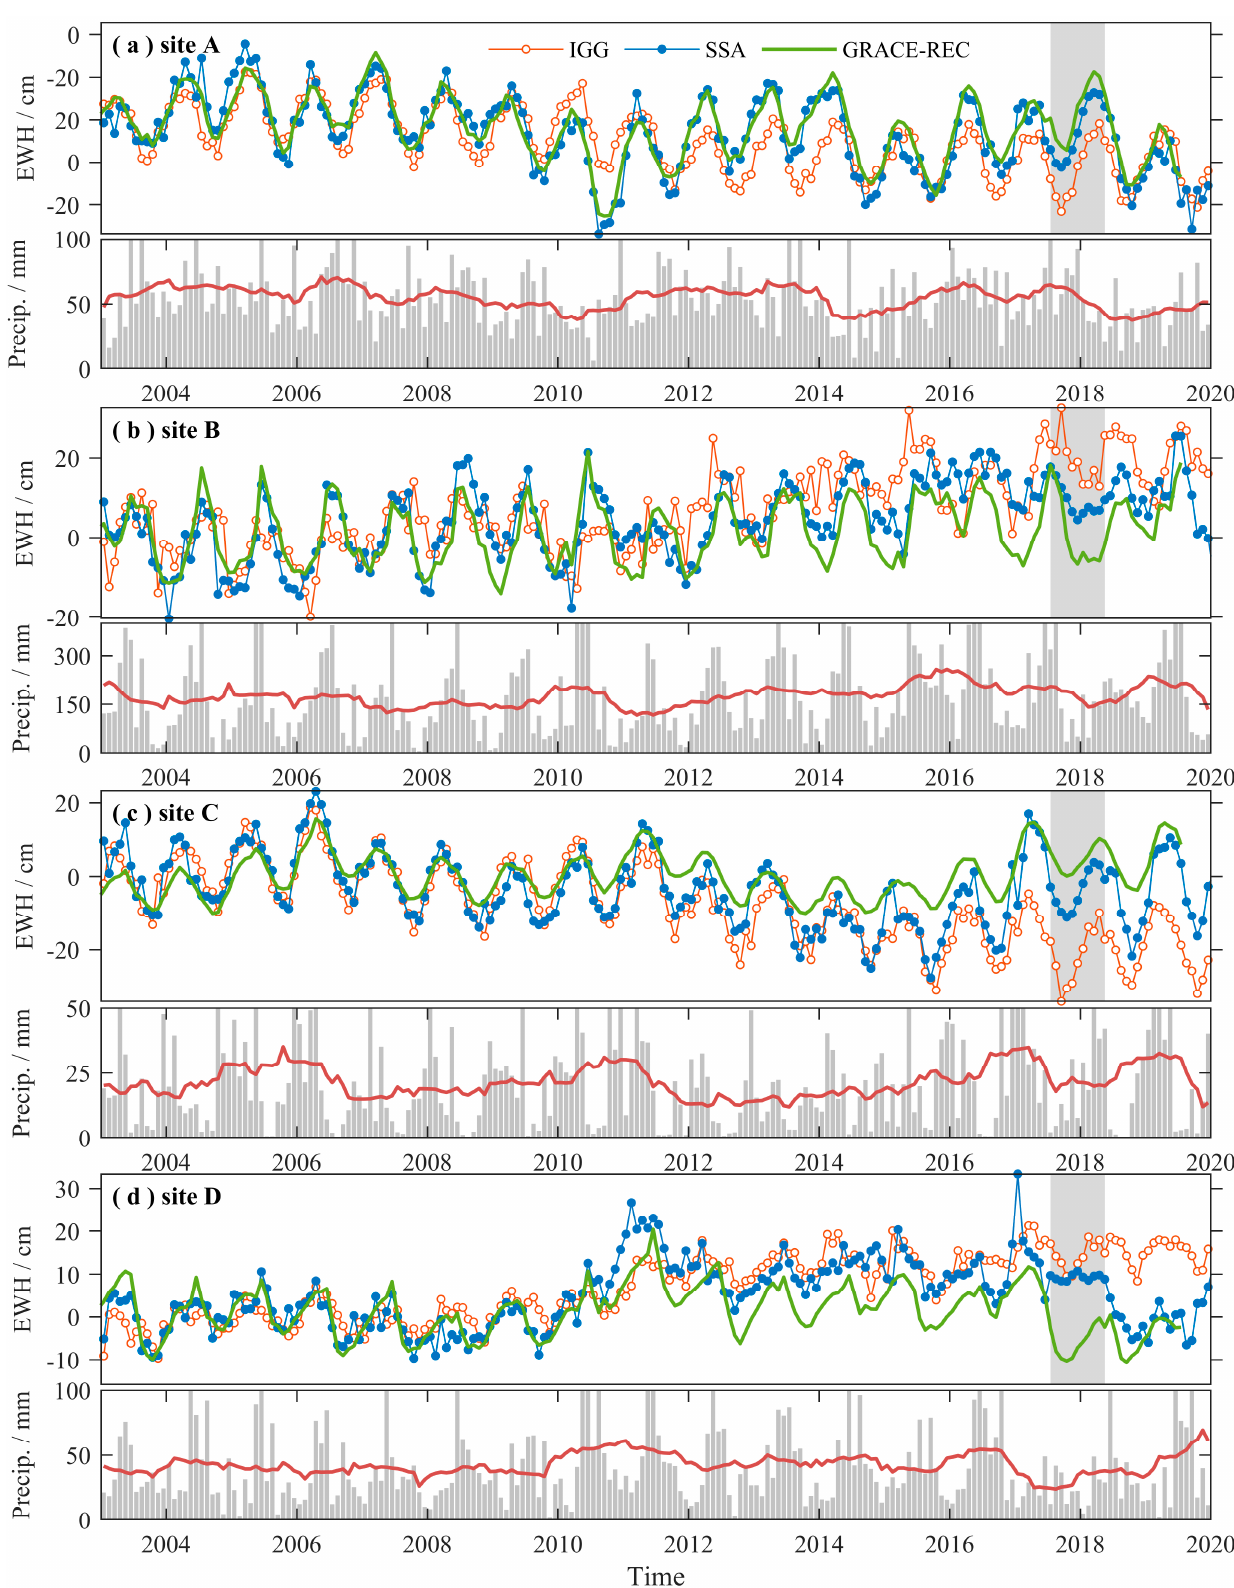
Figure 10. Time series of EWH and precipitation at points A, B, C, and D (marked in Figure 9): ( a ) point A, ( b ) point B, ( c ) point C, ( d ) point D. The red curve in the precipitation plots is the smoothed result of a 12-month sliding window applied to the monthly precipitation (gray